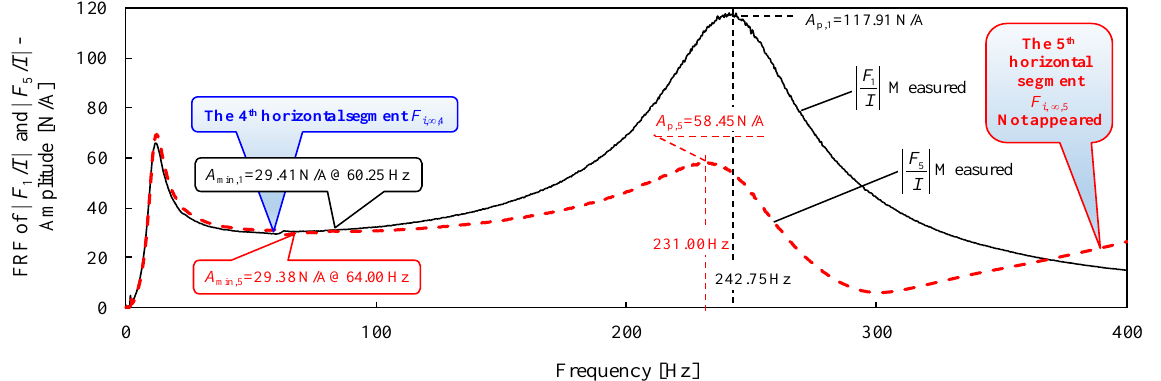
Figure 6. Experimental validation of active FRFs in the fluid-filled state . Key : Measured FRF | F 1 / I | (—); measured FRF | F 5 / I | (- -). The distinct features, f p,1 and A p,1 , can be obtained from the test results. The 4th hori- zontal segment F i , ∞ ,4 is slightly concave and is induced by the mover modal. The lowest point is closest to the 4th horizontal segment; therefore, the minimum value A min